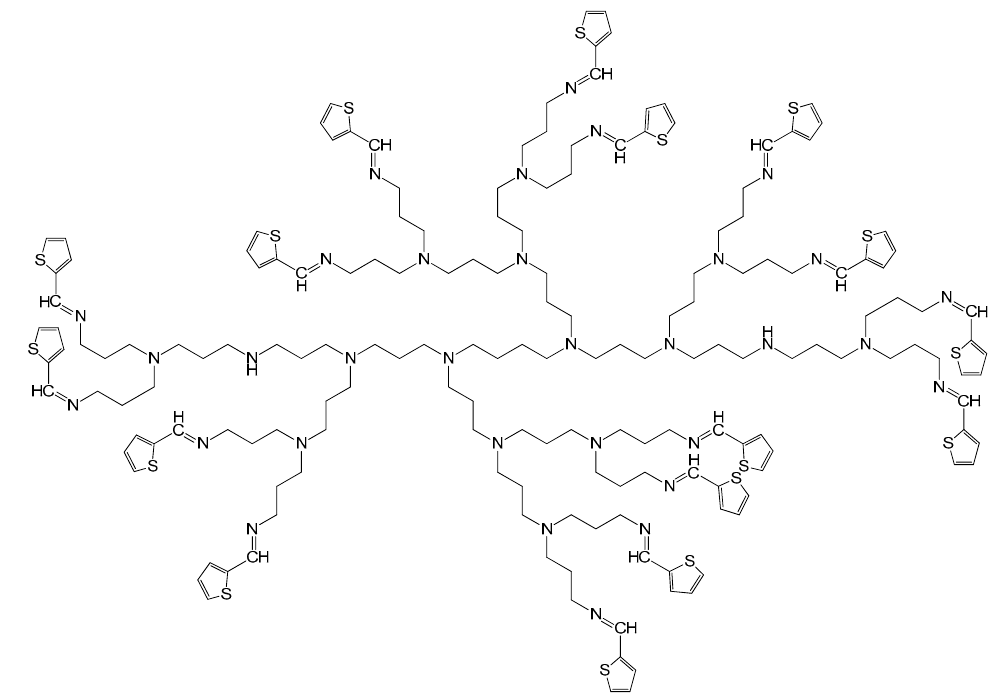
Figure 2. Chemical structure of 3 poly(propylenethiophenoimine) dendrimer (G3PPT).